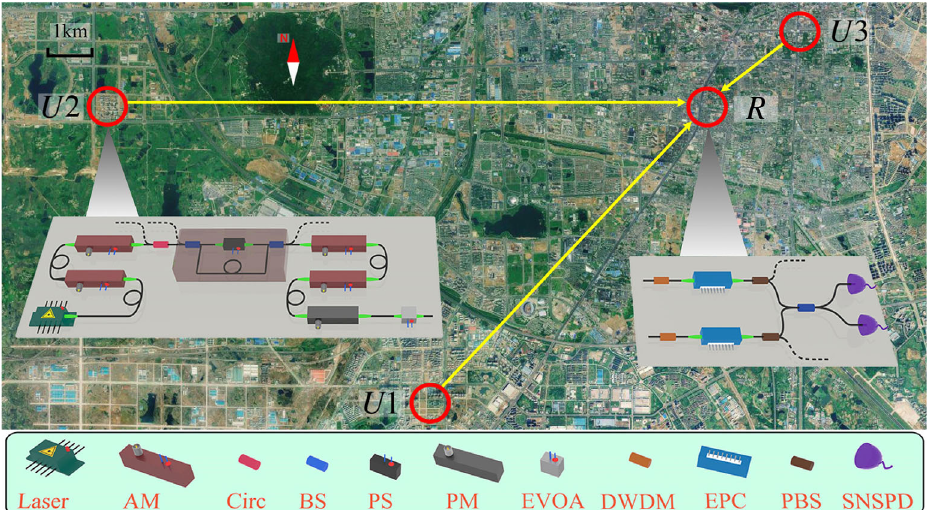
FIG. 2. Birds-eye view of the MDIQKD network topology. User U 1 is placed in an administrative committee (AC) ð N 31 ° 47 0 5 00 ; E 117 ° 12 0 58 00 Þ , user U 2 at the Animation Industry Park in Hefei (AIP) ð N 31 ° 50 0 6 00 ; E 117 ° 7 0 52 00 Þ , and user U 3 in an office building (OB) ð N 31 ° 50 0 57 00 ; E 117 ° 16 0 50 00 Þ . In addition, a central relay R placed in the campus of the University of Science and Technology of China (USTC) ð N 31 ° 50 0 8 00 ; E 117 ° 15 0 47 00 Þ is shared by all the users. The users ’ setup and the relay ’ s BSM setup are shown in the inset. In the user ’ s side, we utilize an internally modulated signal laser and modulate the decoy intensity according to the vacuum þ weak decoy scheme by an amplitude modulator (AM). Then, we adopt a circulator, an asymmetrical Mach-Zehnder interferometer (AMZI), three AMs, and one phase modulator (PM) to encode qubits. The idle ports of circulators and beam splitters for the AMZI are exploited for phase synchronization and feedback, which are represented by the dashed line. After being attenuated by an electrical variable optical attenuator (EVOA), the signal laser pulses are sent via the deployed fiber to the relay comprised of an interference BS and two superconducting nanowire single-photon detectors (SNSPDs). Before the BSM, we adopt a dense wavelength division multiplexor (DWDM) in each input of the BS to block the stray light in the fiber, and we insert an electric polarization controller (EPC) and a polarization beam splitter (PBS) for polarization